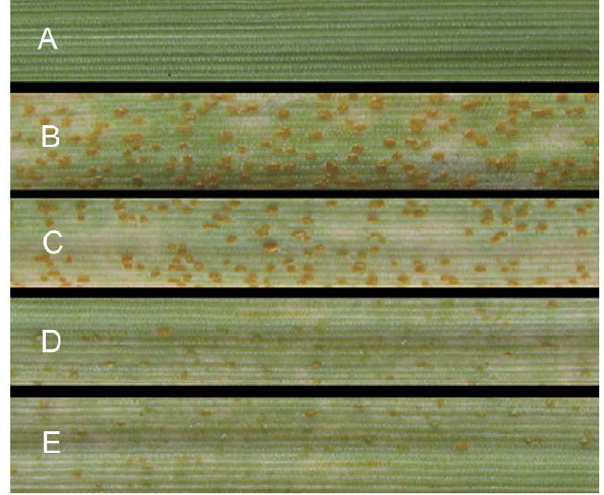
Figure 6. Uredia on silenced leaves 16 days after Pst inoculation. Pst development on wheat leaves after HIGS. A: No virus and Pst (healthy leaf control); B: No virus (normal infection with Pst ); C: BSMV: c :0-as (empty viral vector control); D: BSMV: c : PsCNA1 -as ( Pst infection after silencing PsCNA1 ); E: BSMV: c : PsCNB1 -as ( Pst infection after silencing PsCNB1 ).